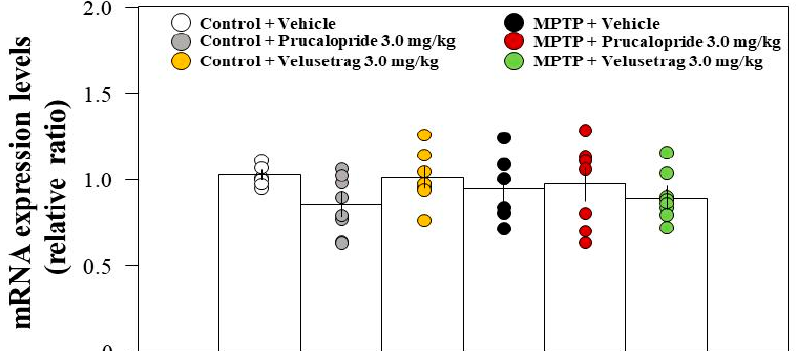
Figure 3. RT-qPCR analysis of the hippocampal mRNA expression levels of 5-HT 4 receptor (5-HT 4 R) in vehicle-administered control and PD mice, and in prucalopride or velusetrag-administered control and Parkinson´s disease (PD) mice. Data are expressed as the mean ± SEM: n = 6–8 per group. No significant differences were observed between groups (one-way ANOVA followed by Tukey’s post-hoc test).